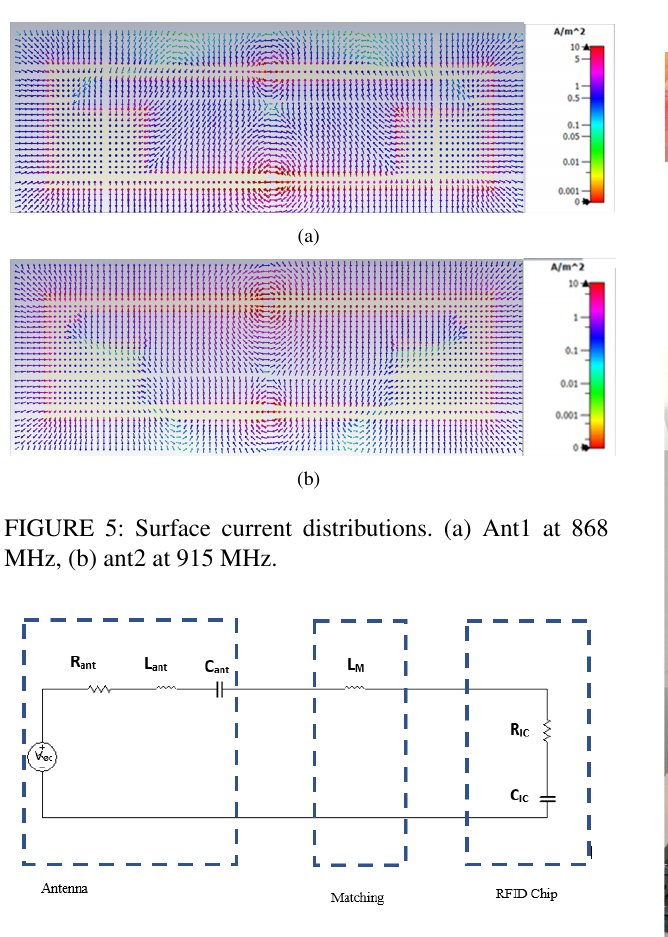
FIGURE 6: Equivalent circuit for the presented RFID tag antenna.